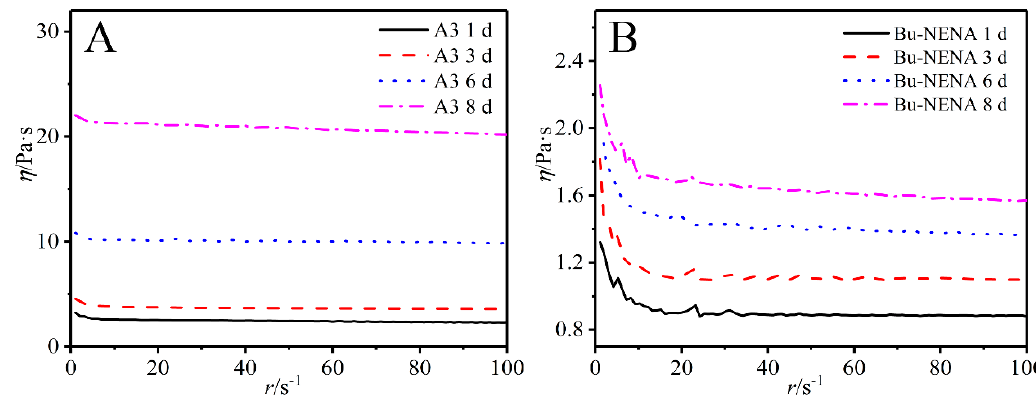
Figure 4. Viscosity curves of PTPET with A3 ( A ) and Bu-NENA ( B ) after different times.